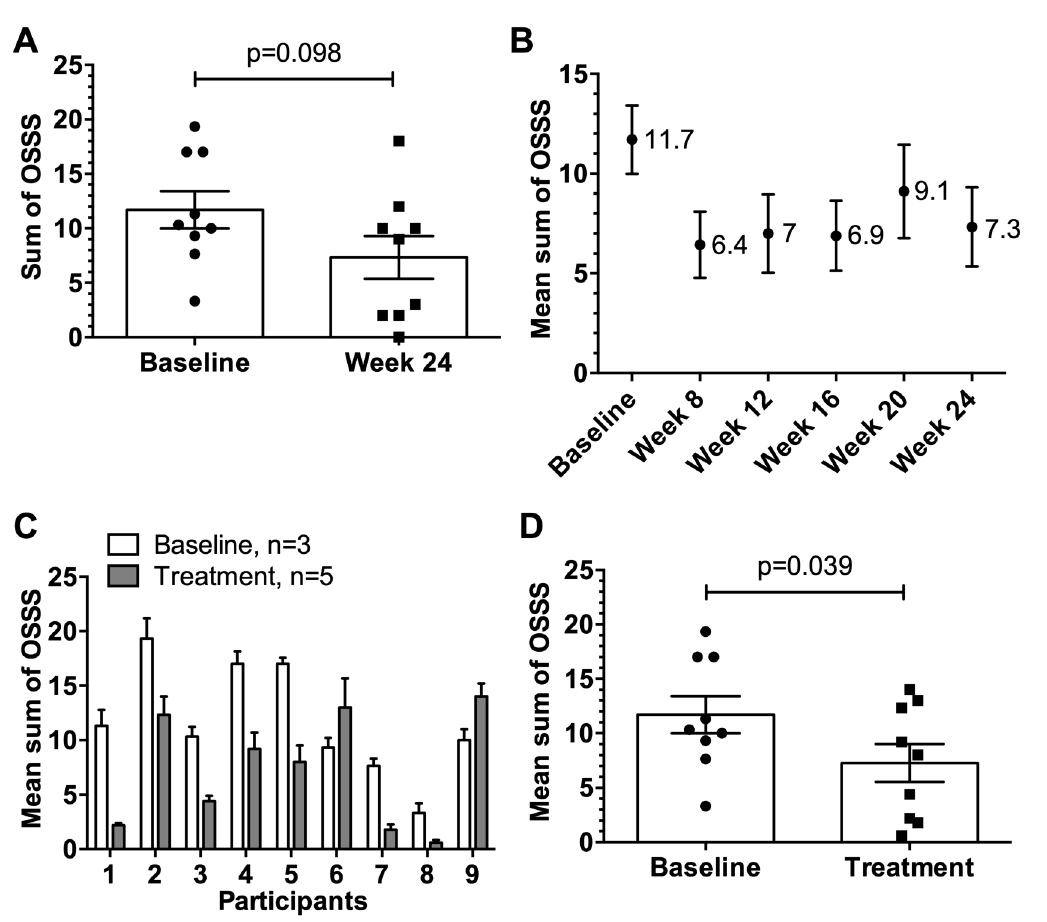
Figure 2. Organ specific symptom score (OSSS) after provocation. ( A ) Individual OSSS with SEM of participants ( n = 9) at baseline versus week 24 at the end of the study. ( B ) Mean OSSS with SEM of participants ( n = 9) at baseline and over the course of the study. ( C ) Individual mean OSSS with SEM comparing baseline (weeks 1–3, n = 3) vs. treatment period (weeks 8, 12, 16, 20 and 24, n = 5). ( D ) Individual mean OSSS ( n = 9) with SEM comparing baseline ( n = 3, weeks 1–3) vs. treatment period ( n = 5, weeks 8, 12, 16, 20 and 24). Statistical significances were obtained by an exact Wilcoxon matched-paired signed rank test. Possible OSSS values from